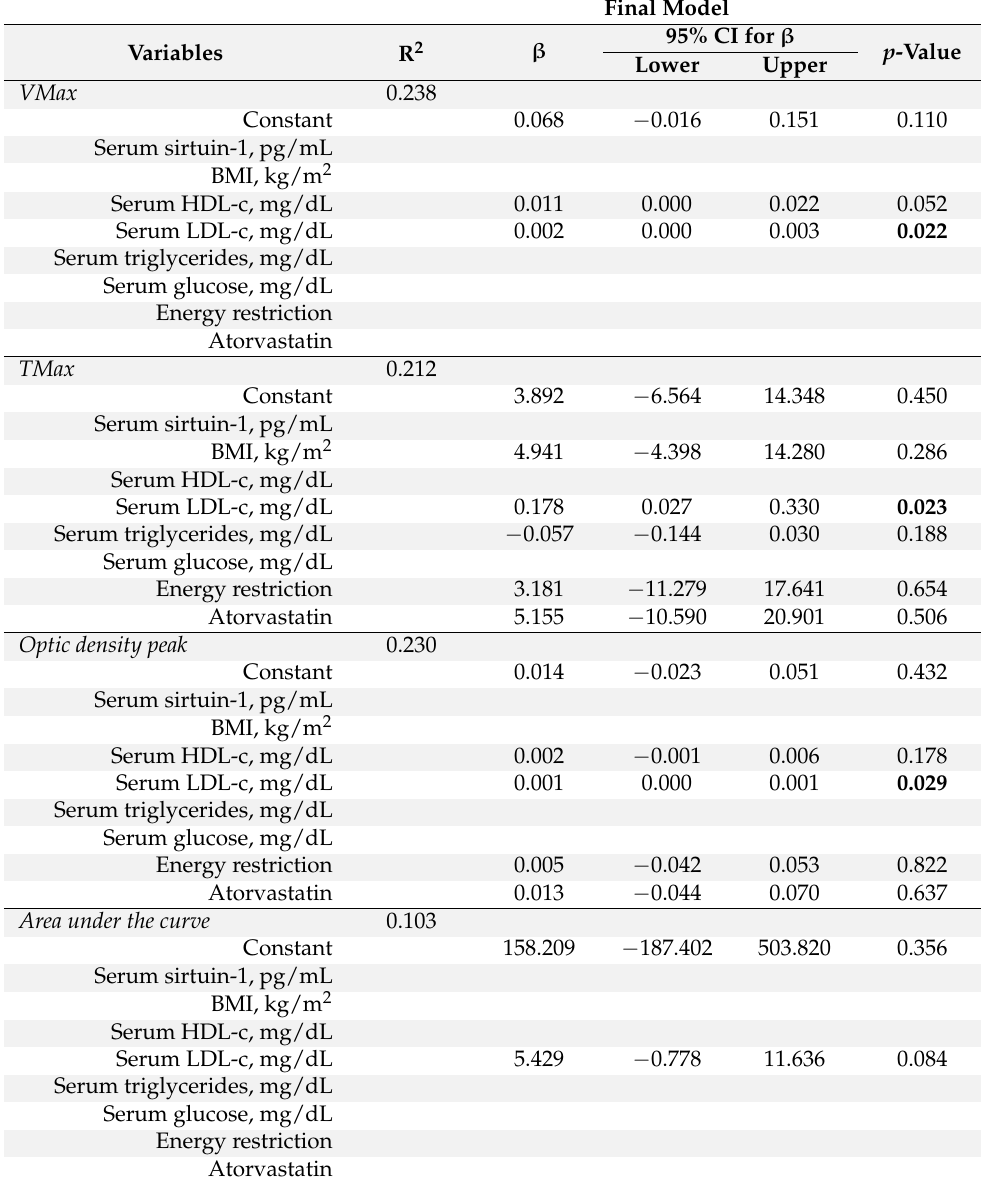
Table 4. HDL particle’s antioxidant capacity.